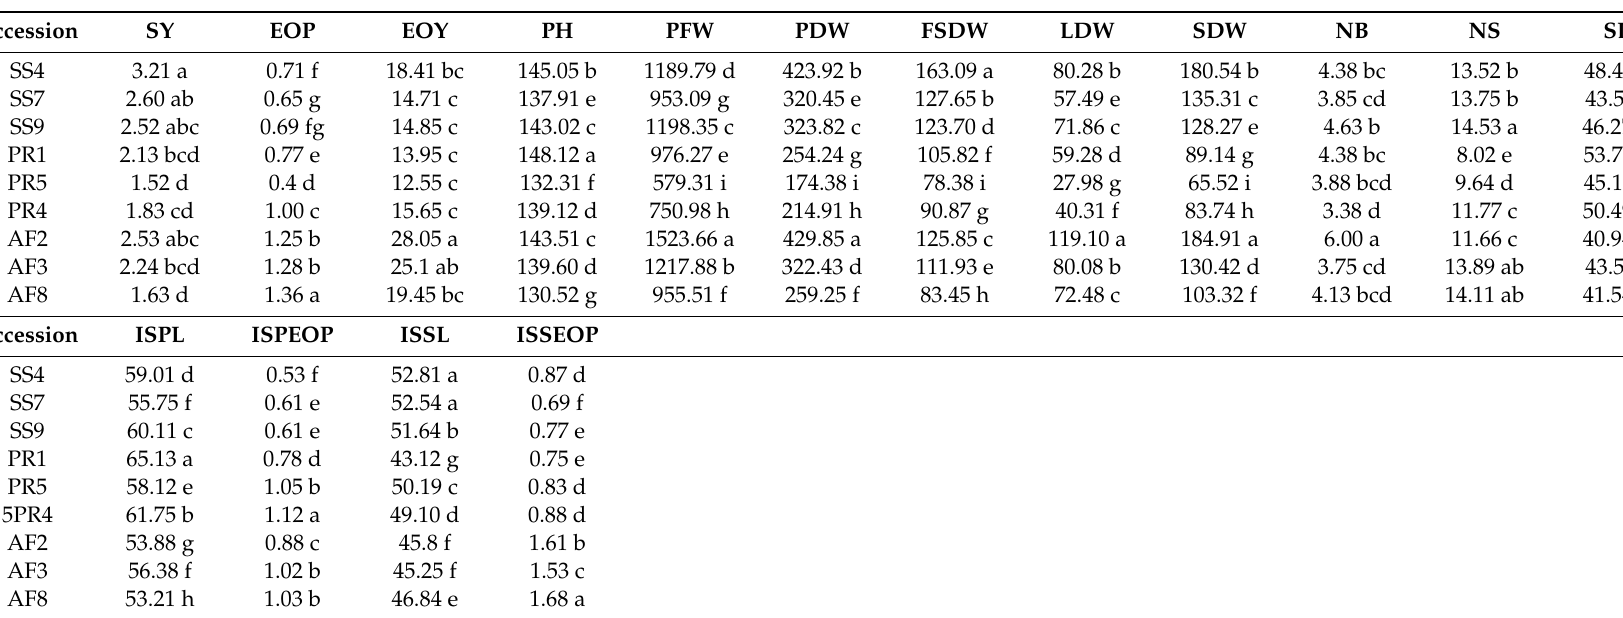
Table 6. Mean values of biometric and production parameters of the accessions over the